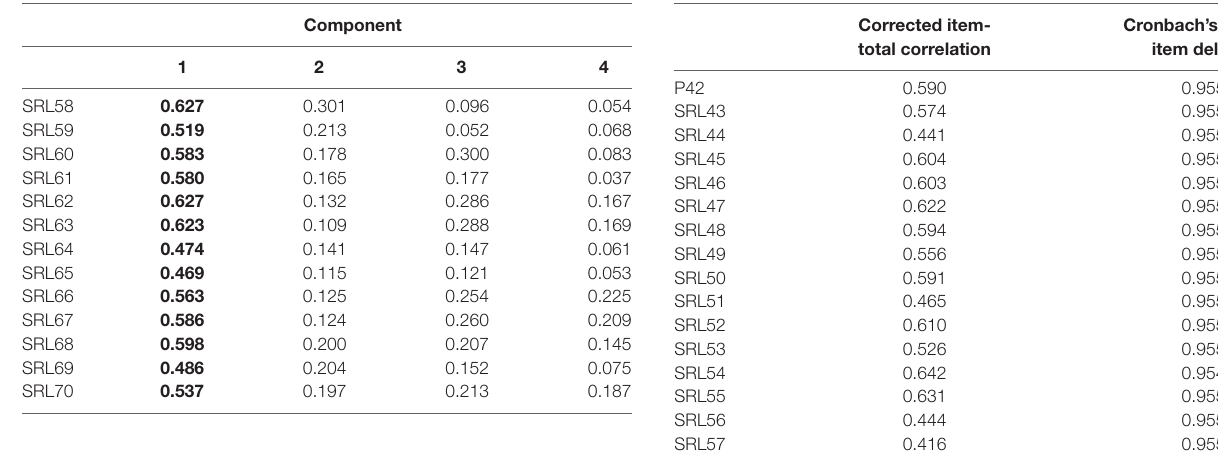
TaBle a4 | Item to Total Correlation Coefficient of ASES-FJHS Final Form.